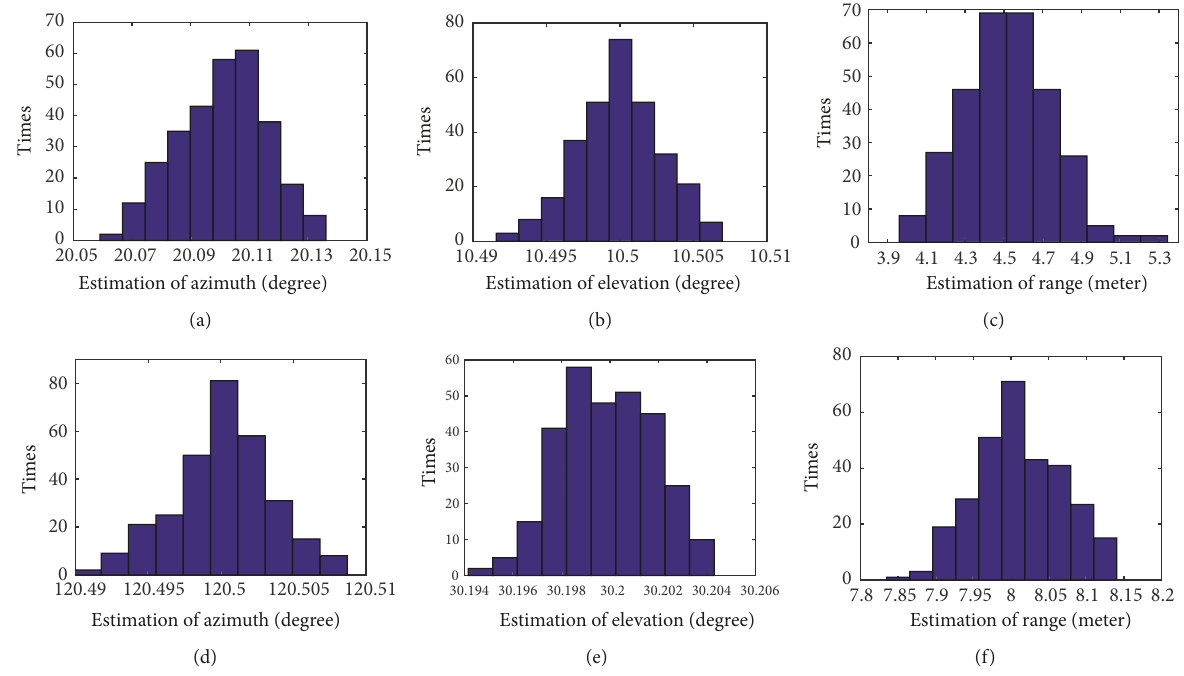
Figure10:Histogramdistributionofsource’s3Dparameterestimation.(a)Azimuthangle (𝑓 = 900 MHz ) .(b)Elevationangle (𝑓 = 900 MHz ) . (c) Range (𝑓 = 900 MHz ) . (d) Azimuth angle (𝑓 = 1.5 GHz ) . (e) Elevation angle (𝑓 = 1.5 GHz ) . (f). Range (𝑓 = 1.5 GHz )